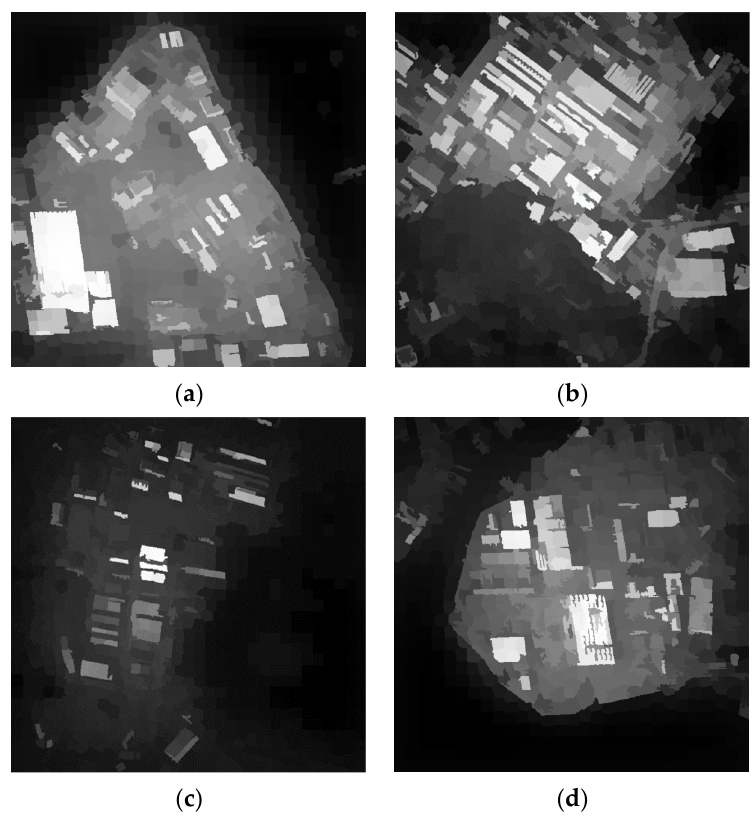
Figure 9. The improved boundary priori saliency maps. ( a ) Image I, ( b ) Image II, ( c ) Image III, ( d ) Image IV.